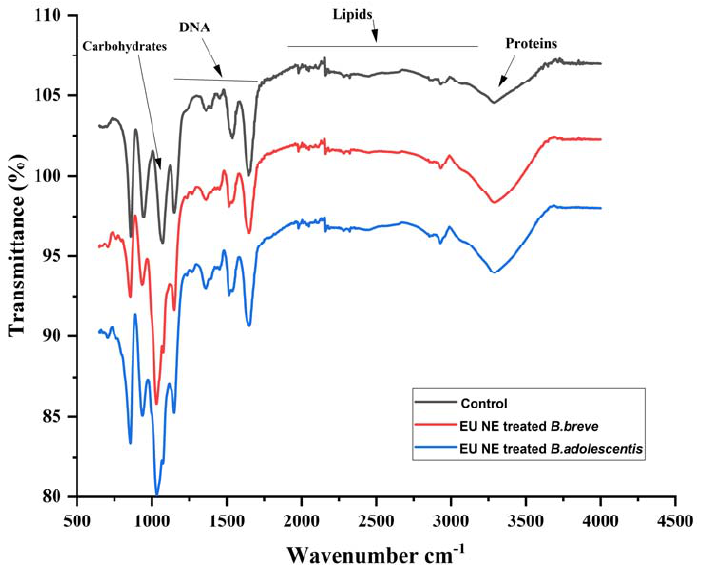
Figure 6. FTIR spectra of B. breve and B. adolescentis untreated (control) and treated with EU nano- emulsion (900 μ m) to elucidate the change in the membrane chemical composition.